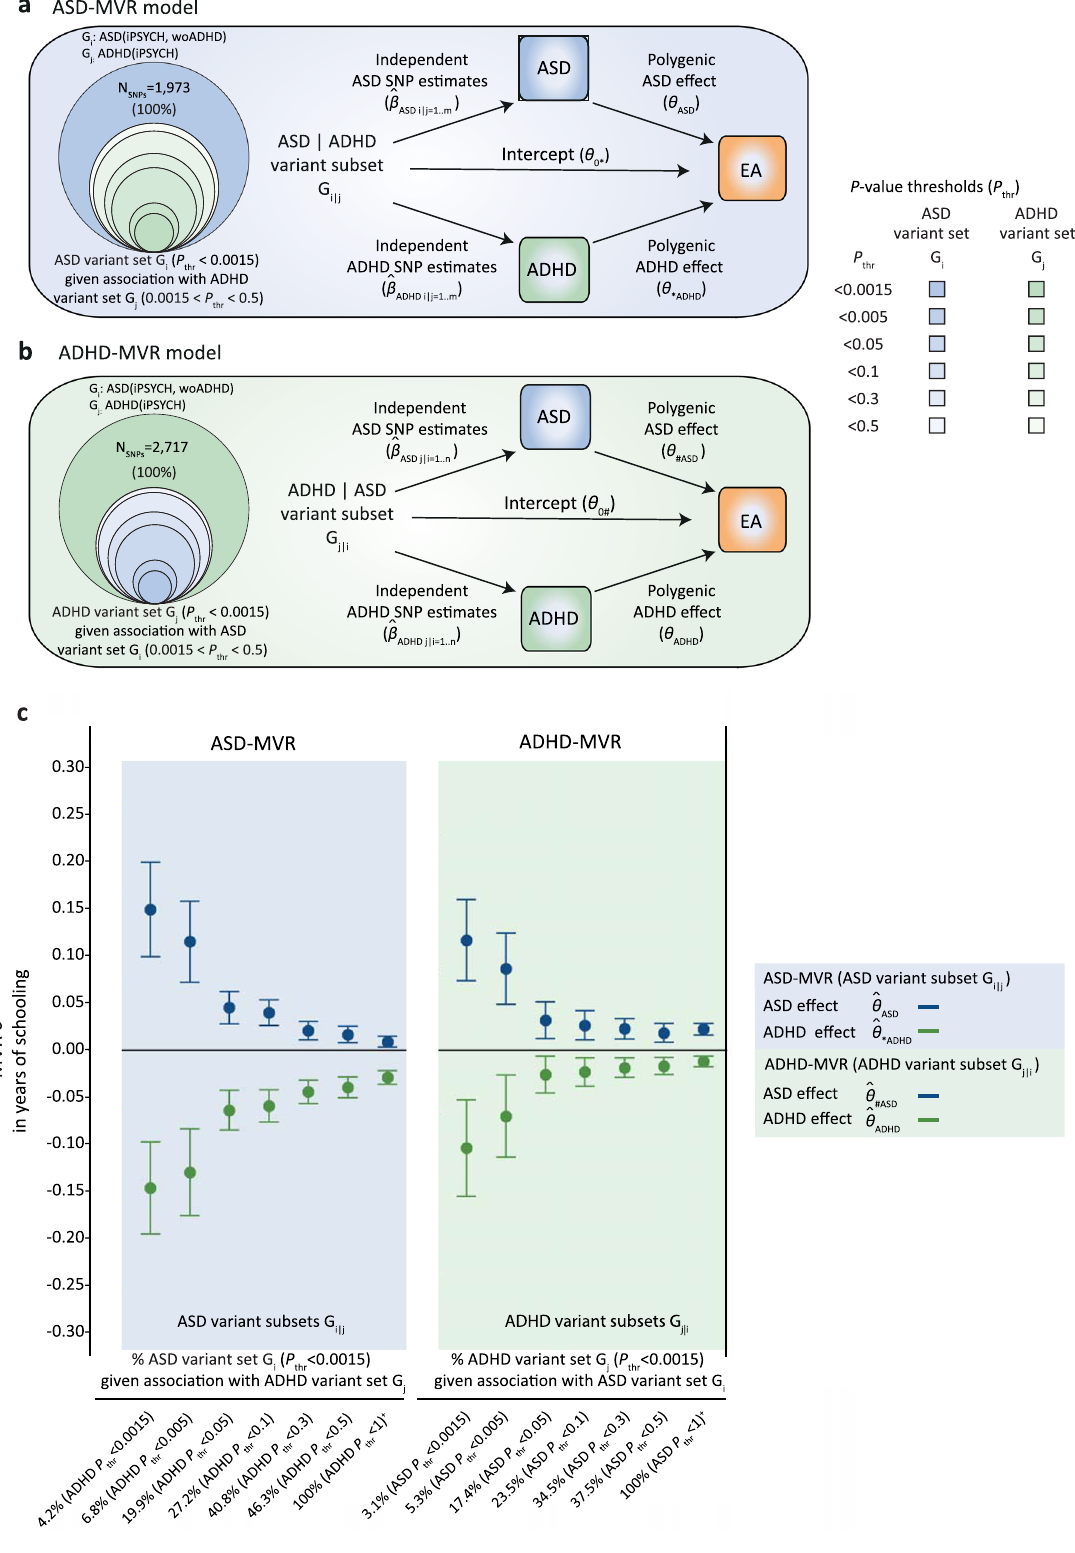
conditional variant sets are nested within each other, we applied the multiple-testing-threshold for discovery analyses (0.0023). Fitting a series of MVRs with conditional variant subsets G i|j and G j|i , increased the size of estimated polygenetic association effects with EA up to fi ve times compared to the polygenic effects observed in discovery analyses, with non-overlapping